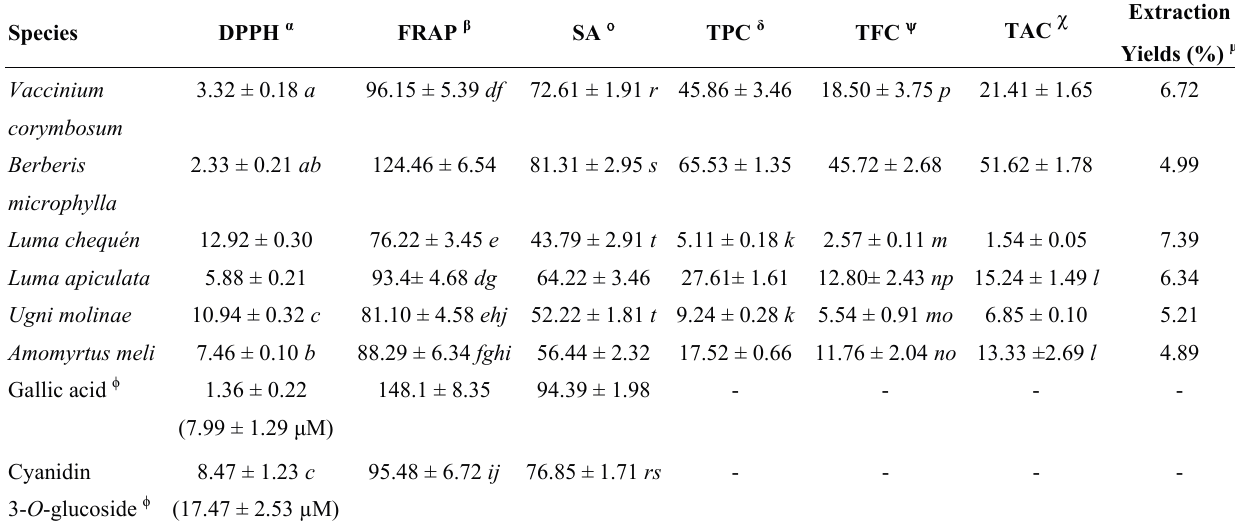
Table 2. Scavenging of the 1,1-diphenyl-2-picrylhydrazyl Radical (DPPH), Ferric Reducing Antioxidant Power (FRAP), Superoxide Anion scavenging activity (SA), Total Phenolic Content (TPC), Total Flavonoid Content (TFC), Total Anthocyanin Content (TAC), and Extraction Yields of Six Edible Berry Fruits From the VIII Region of